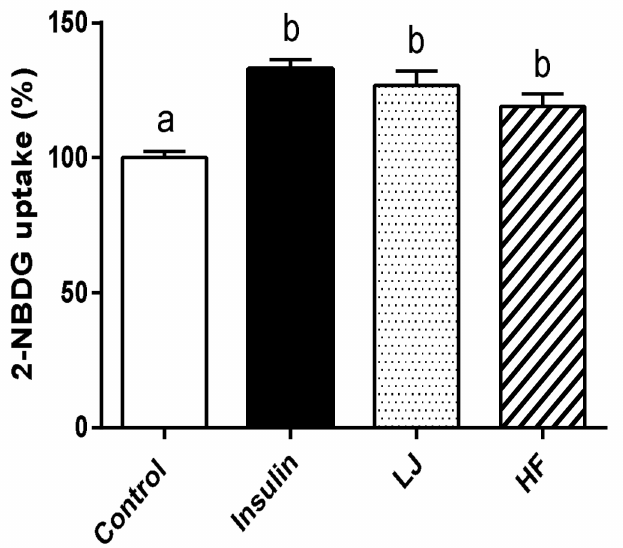
Figure 3. Effects of LJ and HF extracts on glucose uptake in C2C12 muscle cells. Data are represented as the mean ± SEM of three independent experiments. a,b : Values that do not share the same superscript are significantly different by ANOVA ( p <